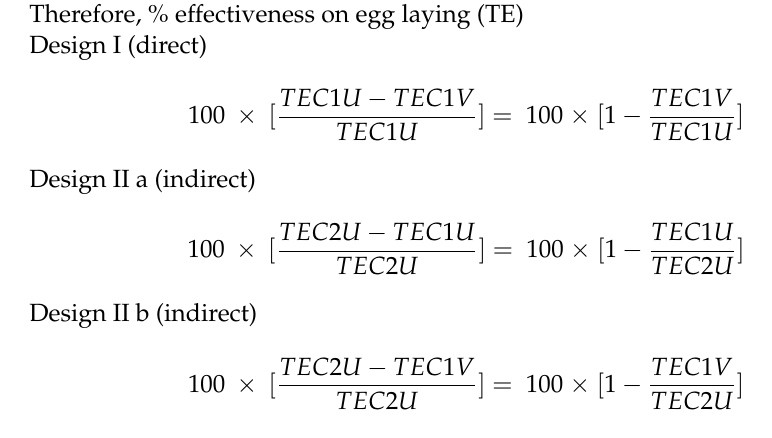
from each other. The vaccine-induced effect on ticks from the cattle populations is determined as: Design I: a comparison between effects on ticks from vaccinated and unvaccinated cattle in Population 1. Design II a: a comparison between effects on ticks from unvaccinated cattle in Population 1 and unvaccinated cattle in Population 2. Design II b: a comparison between effects on ticks from vaccinated cattle in Population 1 and unvaccinated cattle in Population 2. Design III: a comparison between effects on ticks from both vaccinated and unvaccinated cattle in Population 1 and unvaccinated cattle in Population